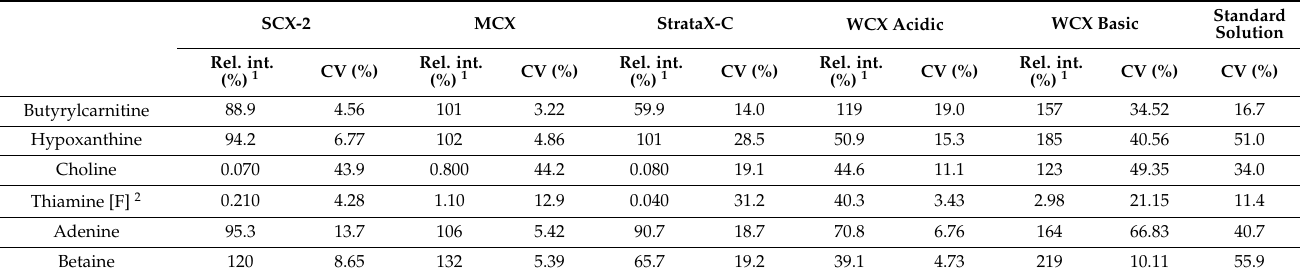
Table A1. Summary of relative peak area 1 and CV (%) of all analytes as well as Na + for all tested SPE protocols in standard solution. 1 mean of SPE replicates/mean of standard solution replicates expressed as percent (%), 2 The analytes were detected as